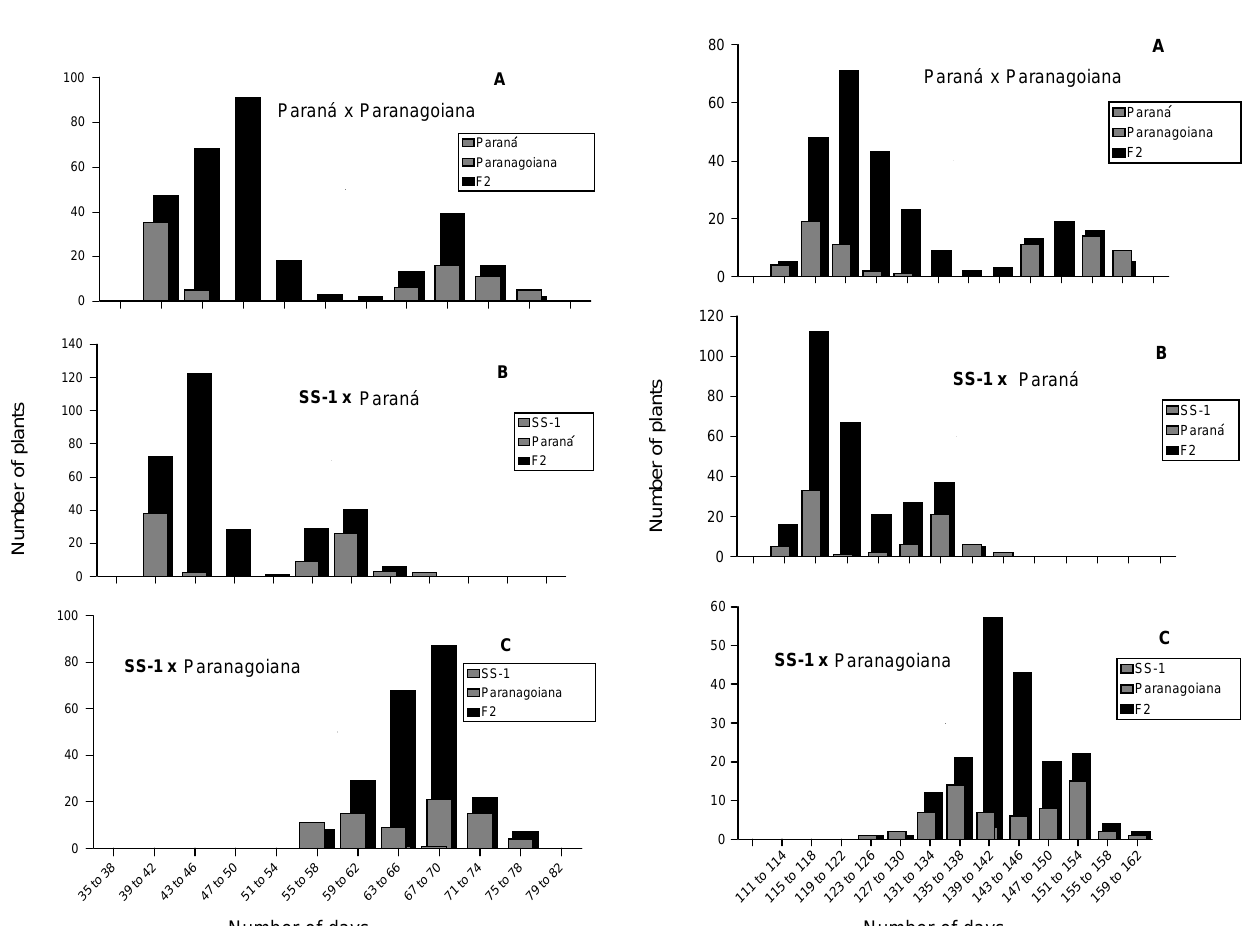
Figure 2 - Frequency of plants of parents and of F generations for the num- 2 ber of days to maturity in three soybean